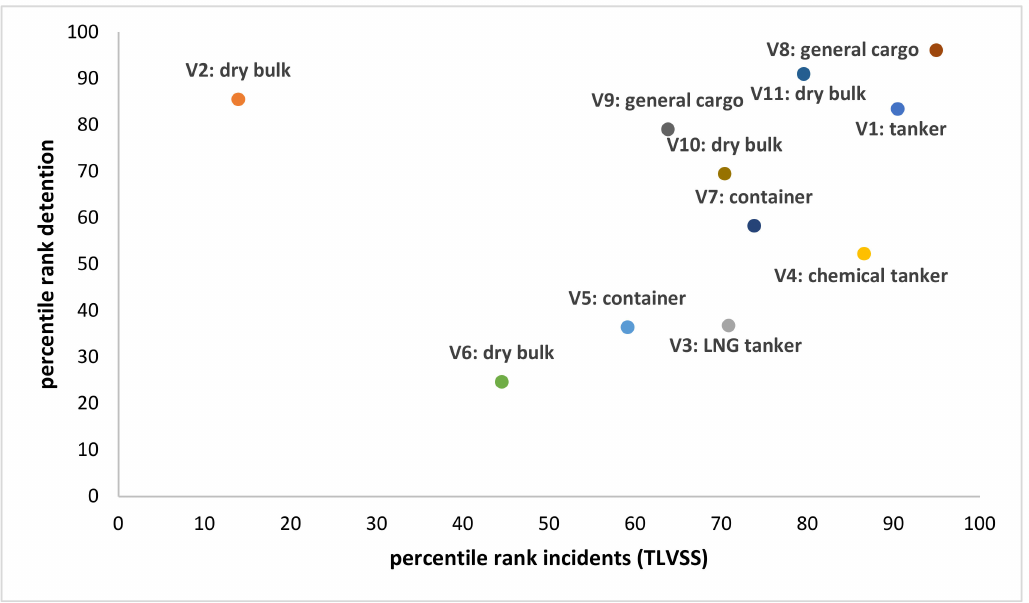
Figure 5. Example of visualization of risk dimensions of vessels in